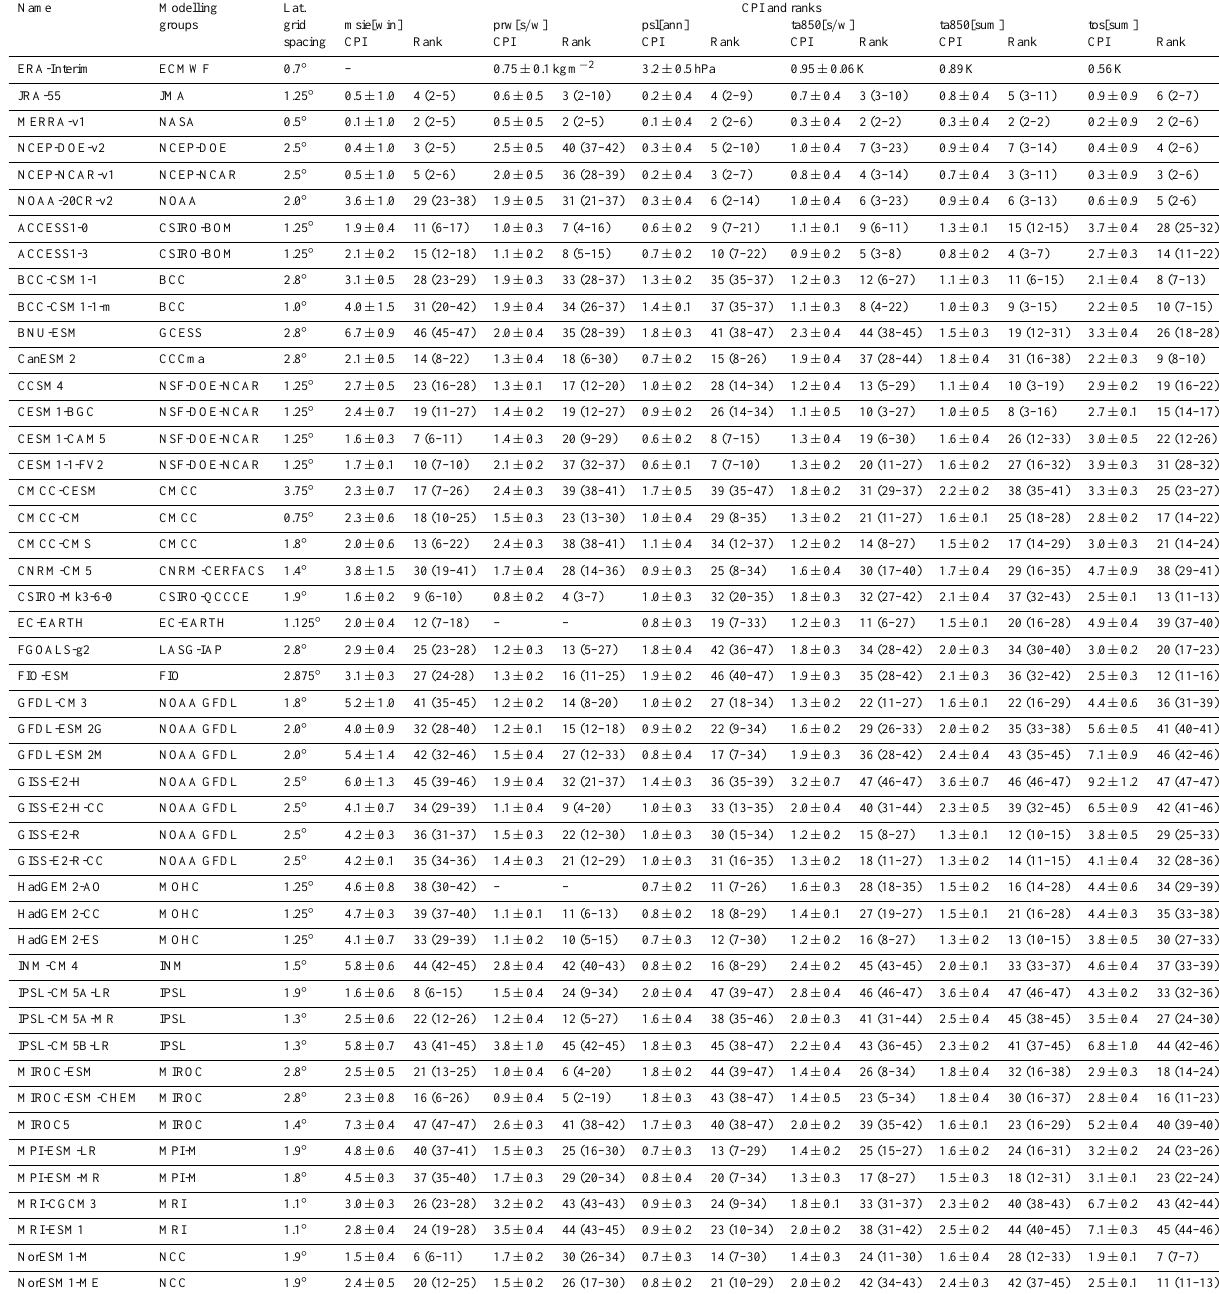
Table 1. Reanalyses (first six rows) and CMIP5 model details. Climate prediction indexes (CPIs) are given plus/minus estimate of the multi- decadal variability. Ranks given in parentheses are the modified ranks when using CPI plus/minus multi-decadal variability for the considered model while not changing CPIs of other models. On the ERA-Interim line, we give the ERA-Interim standard deviation of spatially averaged annual values, which are the scaling factors for the indexes, and when combining several seasons we give the mean standard deviation plus/minus